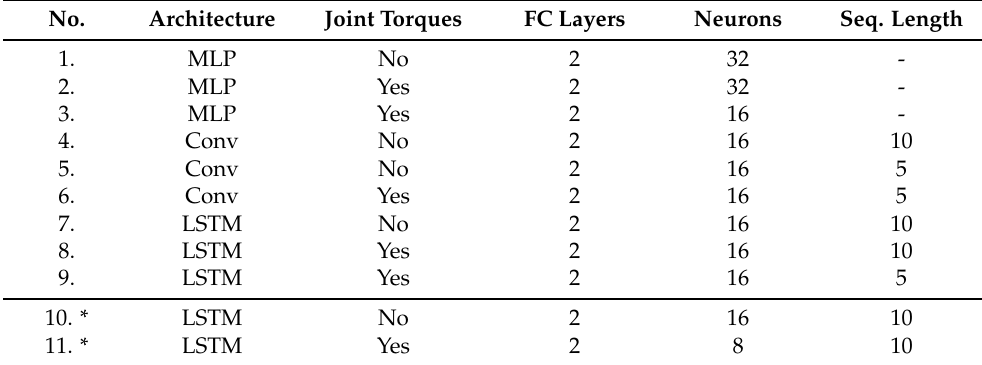
Table 1. Trained neural networks with selected